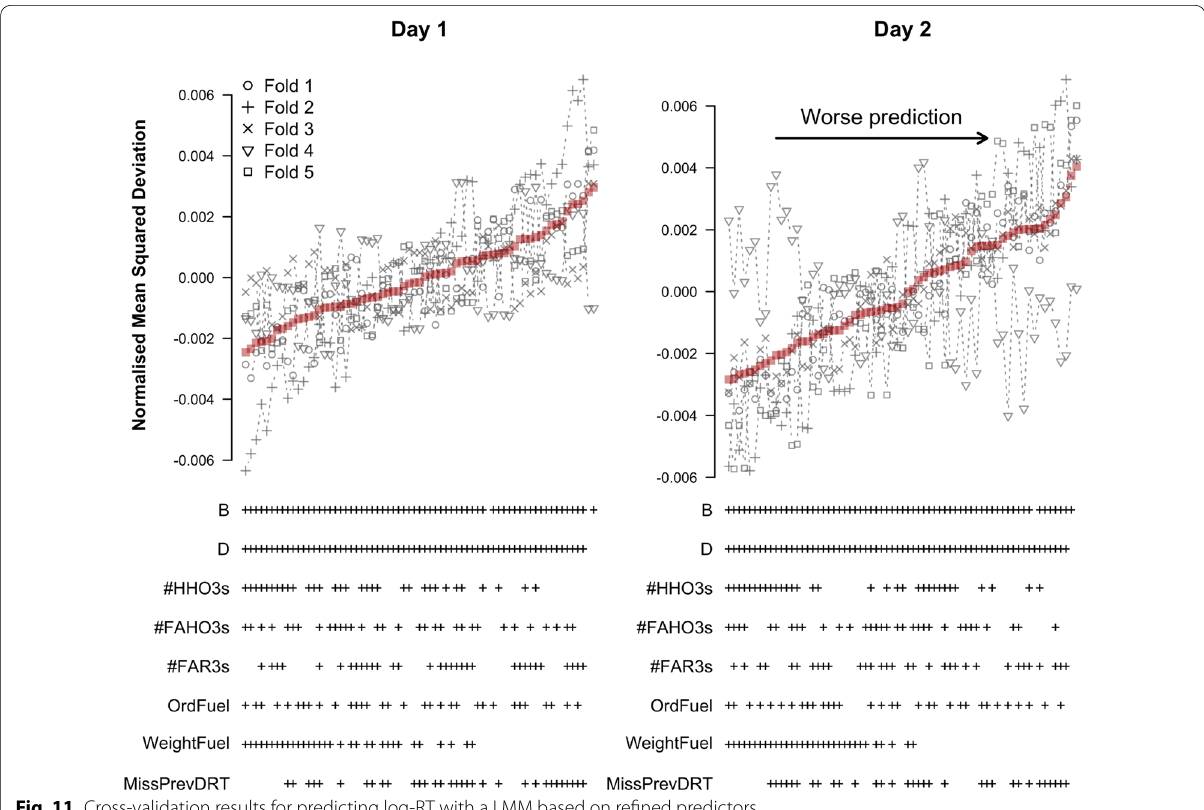
Fig. 11 Cross-validation results for predicting log-RT with a LMM based on refined